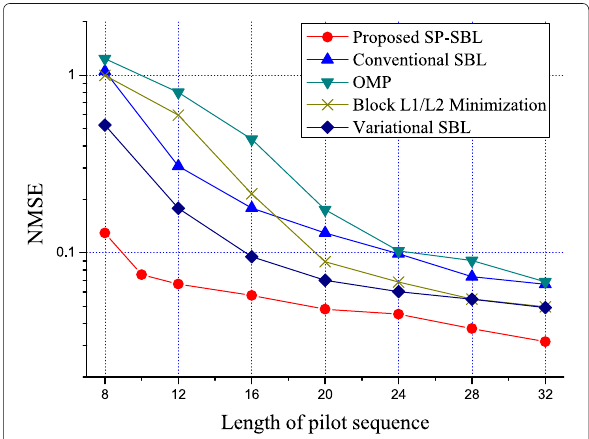
Fig. 2 NMSE performance for different lengths of pilot sequence T , where N = 64 and M = 4. The transmit SNR of BS is NP σ the angular spread is (cid:3) d = 5